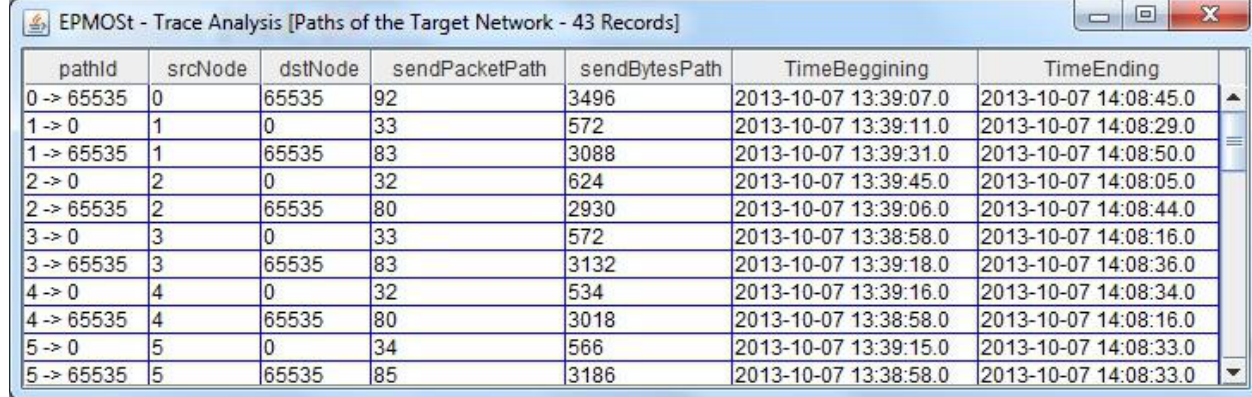
Figure 8. Example of information about the paths of the target